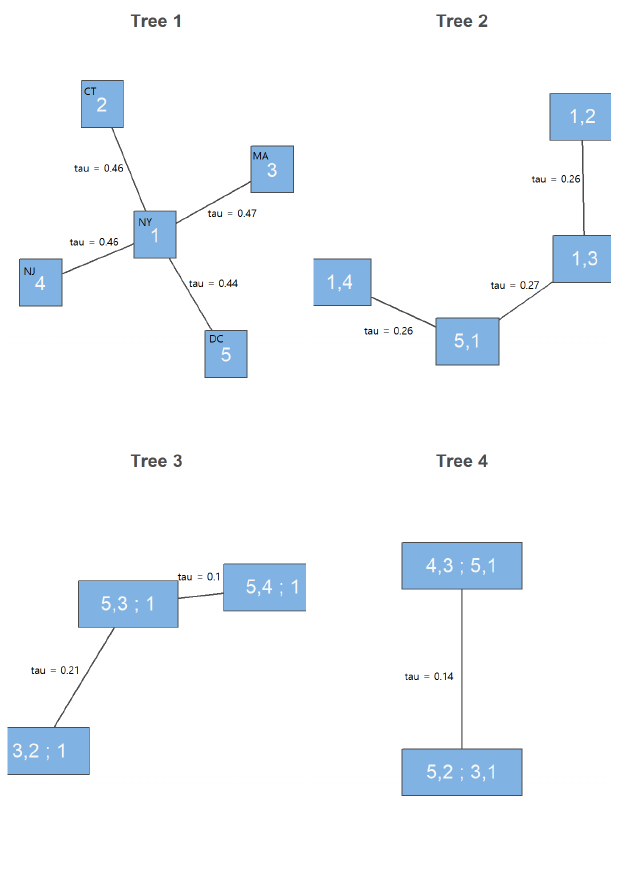
Figure 7. R-vine copula model-based hierarchical tree structure plots of daily COVID-19